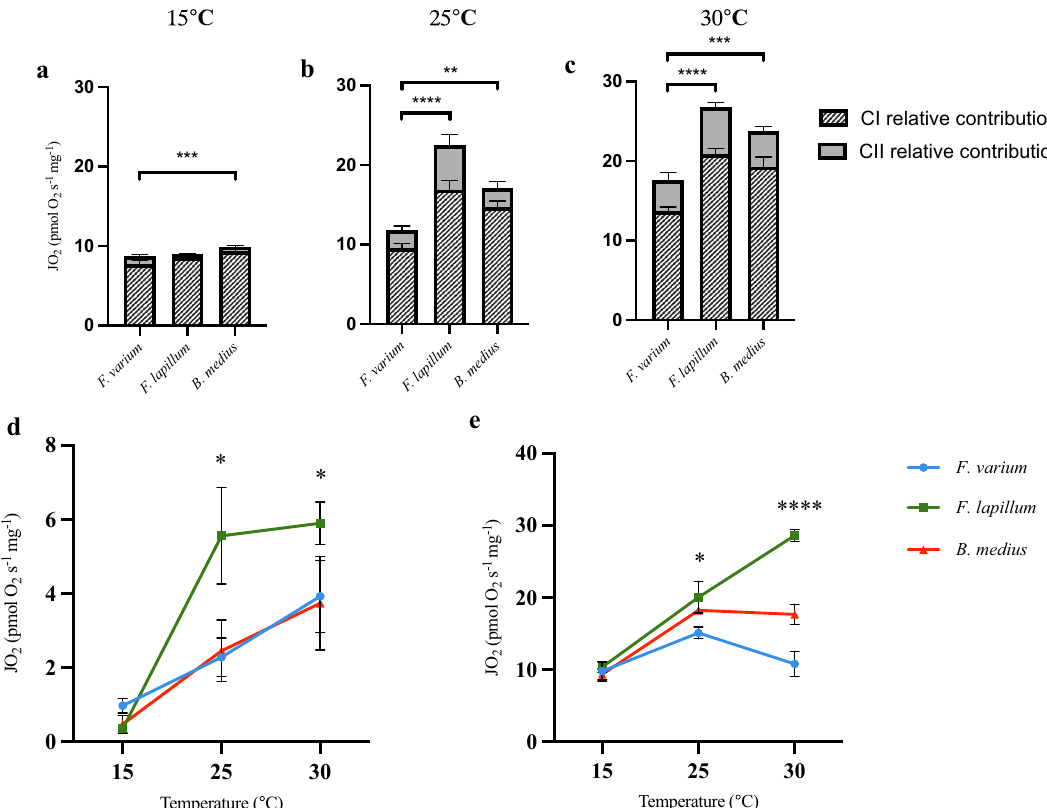
Figure 4. Complex contributions (CI&CII) to OXPHOS and reserve respiratory capacity of mitochondria at 15, 25 and 30 °C. ( a – c ) Complex I (CI and complex II (CII) contribution to OXPHOS by temperature ( a ; 15 °C, b ; 25 °C, c ; 30 °C). ( d ) Complex II activity contribution to OXPHOS across temperature. ( e ) Respiratory reserve capacity calculated as ETS-CI&CII OXPHOS across temperature. Significant differences between species within temperature of p ≤ 0.05 are denoted by an asterisk (*), significant differences of p ≤ 0.01 are denoted (**) while differences of p ≤ 0.0001 are denoted